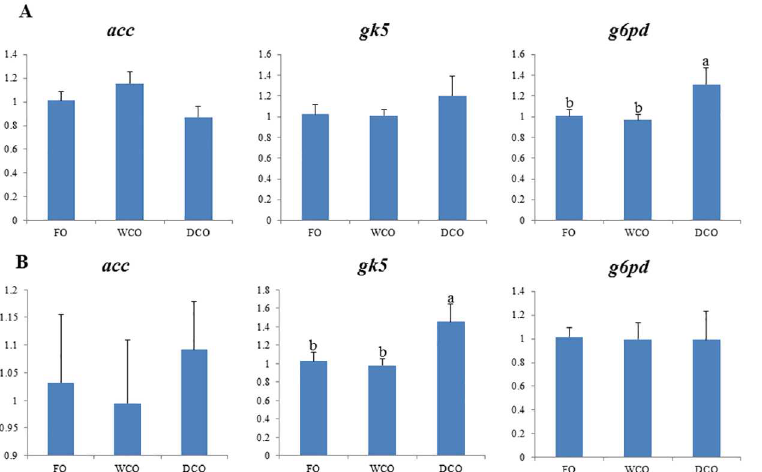
Fig 11. Expression of genes involved in lipogenesis and carbohydrate metabolism in Atlantic salmon midgut (A) and hindgut (B) as determined by qPCR. Results are normalizedexpression ratios (means ± SEM; n = 6). FO, fish oil diet; WCO, wild type camelinaoil diet; DCO, EPA+DHA camelinaoil diet. Fas , fatty acid synthase; acc , acetyl CoA carboxylase; gpi , glucose-6-phosphate isomerase; gys , glycogen synthase; pfk , phosphofructokinase; pk , pyruvate kinase; g6pd , glucose-6-phosphatedehydrogenase; gk5 , glycerolkinase 5.